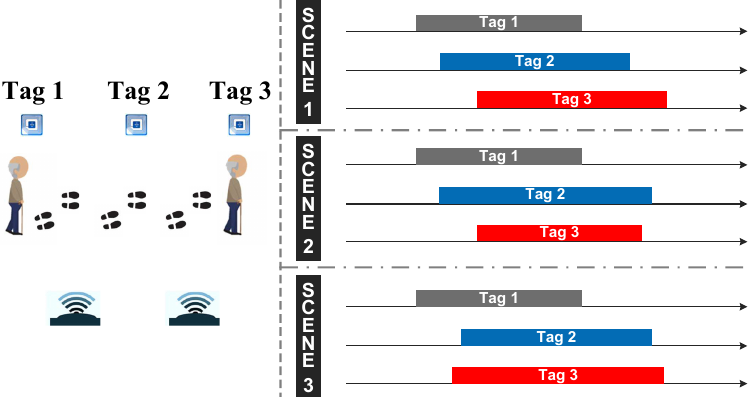
Figure 8. Three special targets’ affected sequence